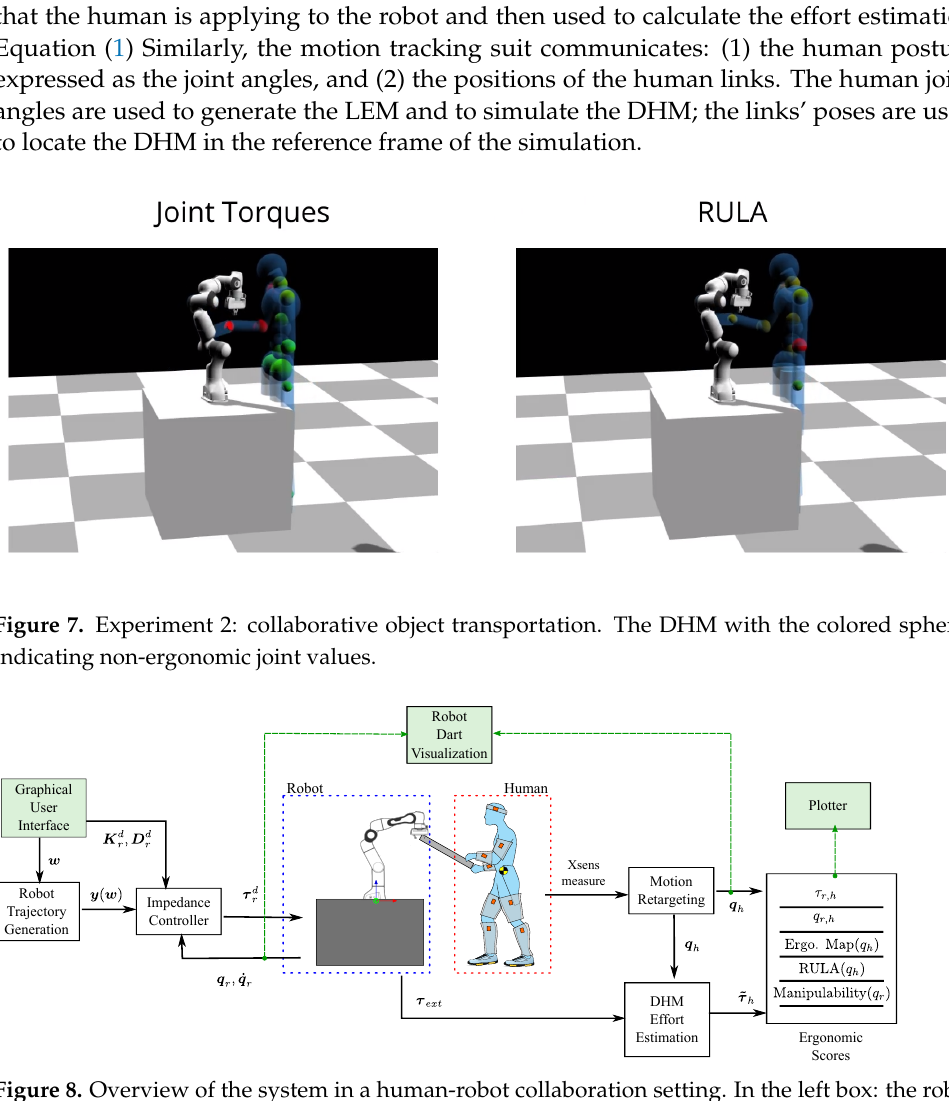
Figure 8. Overview of the system in a human-robot collaboration setting. In the left box: the robot modules that enable to control the robot and retrieve information about the contact forces exchanged with the human. The human-robot interaction force is measured on-line thanks to the joint torque sensors embedded in the robot. Each of the 7 axis is equipped with a torque sensor, and based on these torques measurements, the Franka API provides an estimation of the interaction force at the end-effector. In the right box: modules for online estimation of the human kinematics, dynamics, ergonomics scores and visualization tools. Green boxes: the framework includes visualization tools to plot the online ergonomics scores and other relevant quantities, as well as visualizing the human and the robot interacting in a digital twin based on Dart physics